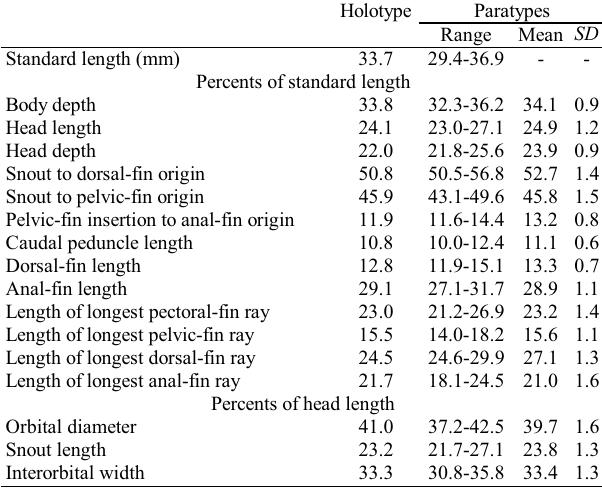
Table 1. Morphometric data of Knodus shinahota (n= 23).